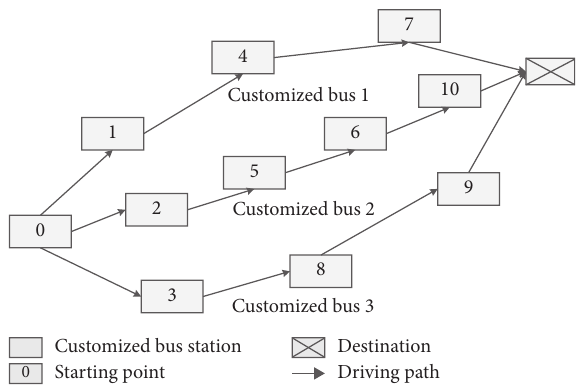
Figure 3: Customized bus optimization